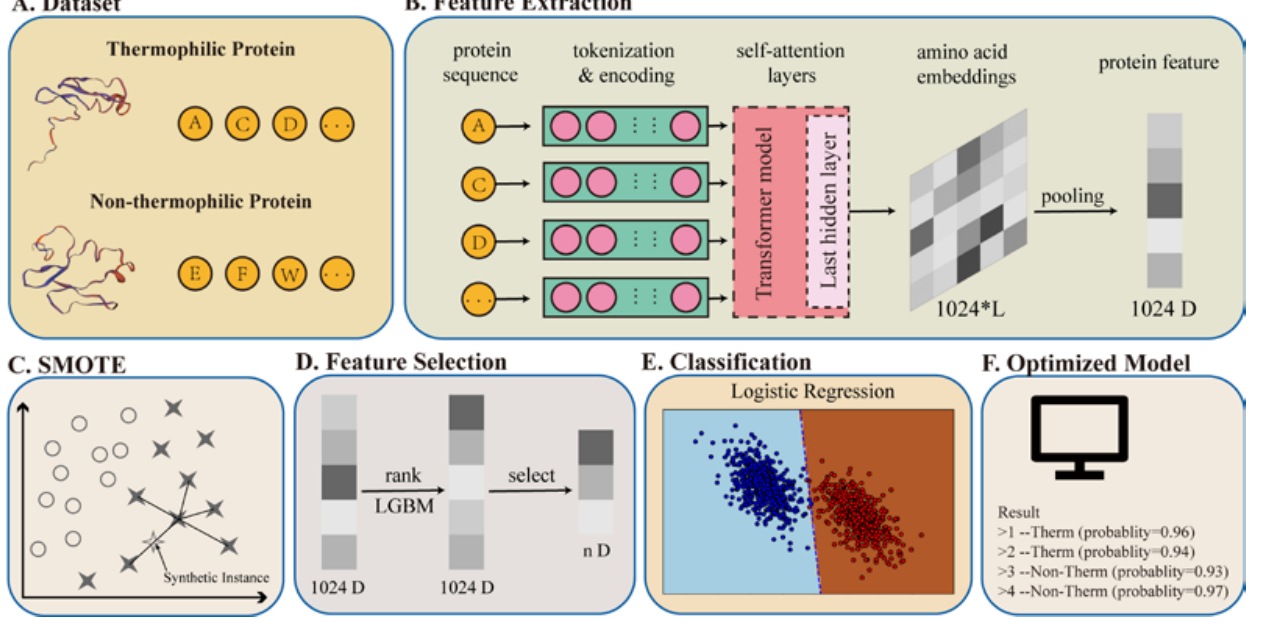
Figure 1. Technology roadmap. ( A ) is the database of thermophilic and non-thermophilic protein sequences as input for feature extraction. ( B ) is the feature extraction part using the BERT-bfd to convert the sequence information into a 1024-dimensional feature vector. ( C ) is to balance the dataset using SMOTE. ( D ) is the feature selection part, which uses the LGBM to sort features in the 1024-dimensional feature vector, and selects the top n features as the input of the classifier. ( E ) naïve is the classifier using the Logistic Regression to train the model. ( F ) is a source code package we build which can predict the thermophilic characteristic of the sequences on user’ computer.